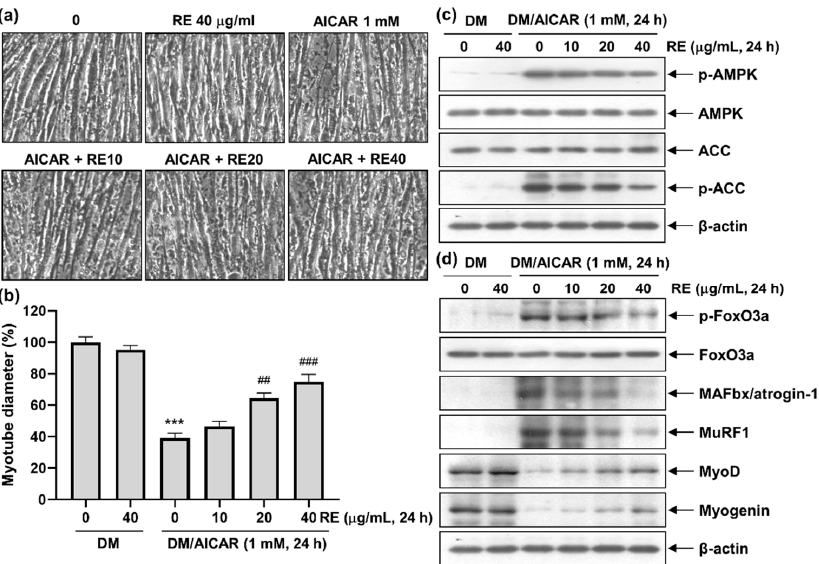
Figure 5. Effects of rosemary extract (RE) on 5-aminoimidazole-4-carboxamide ribonucleoside (AICAR)-induced muscle cell atrophy in C2C12 myotubes. C2C12 cells were cultured in a differentiation medium for 6 d, until fully differentiated, cultured with or without 1 mM AICAR for 24 h, and then cultured with or without RE for an additional 24 h. ( a ) Phase-contrast micrographs of C2C12 cells after differentiation when cultured with AICAR and/or RE. 200 × magnification; ( b ) C2C12 myotube diameter when differentiated with AICAR and/or RE. Values and error bars indicate means ± SD of three separate experiments. ***, significant difference between AICAR- and vehicle-treated cells after differentiation (ANOVA, p < 0.001); ##, significant difference between AICAR-treated cells cultured with and without RE (ANOVA, p < 0.01); ###, significant difference between AICAR-treated cells cultured with and without RE (ANOVA, p < 0.001); ( c ) Effects of AICAR with or without RE on AMPK signaling in C2C12 cells. Western blot analysis was performed using β -actin as a loading control. Representative results of three independent experiments are shown; ( d ) Effects of AICAR with or without RE on the expression of C2C12 myoblast differentiation factors. Western blot analysis was performed using β -actin as a loading control. Results represent three separate experiments. DM: differentiation